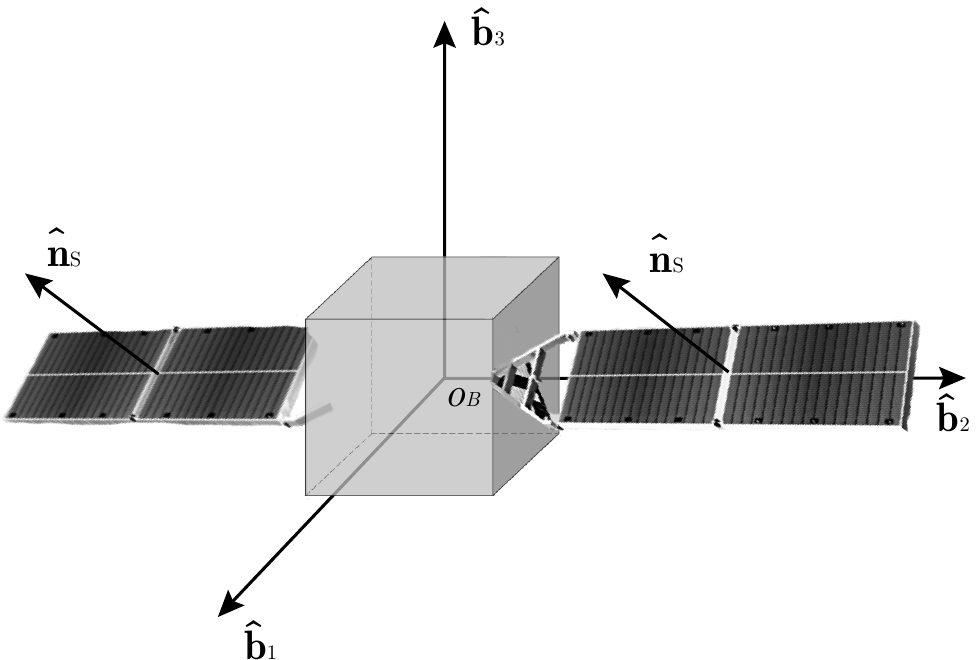
Figure 1. Spacecraft body reference